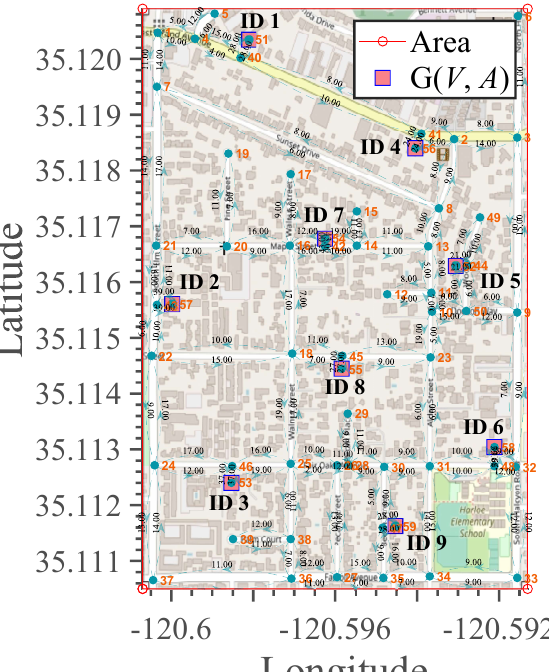
Figure 10. Case B: Weights assigned to each track section with microscopic analysis in an area of 0.9887 km 2 .